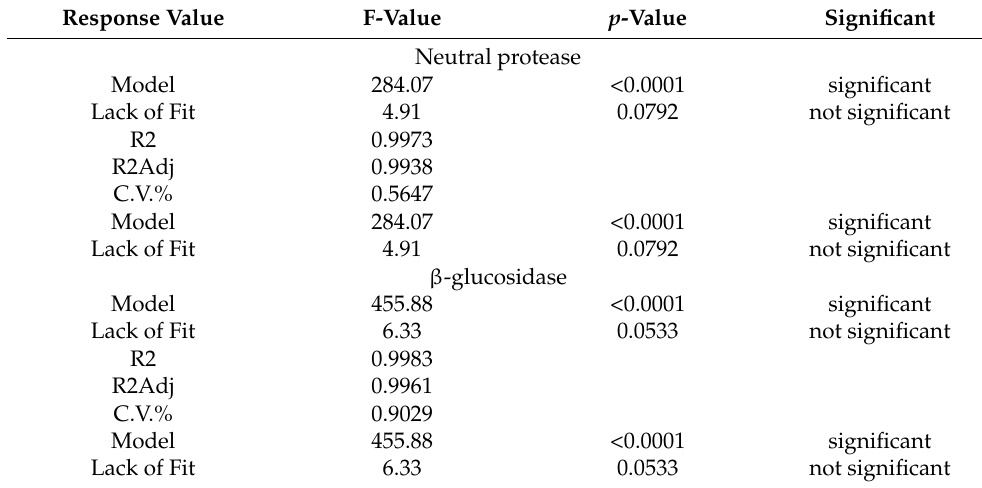
Table 3. The ANOVA analysis of the quadratic